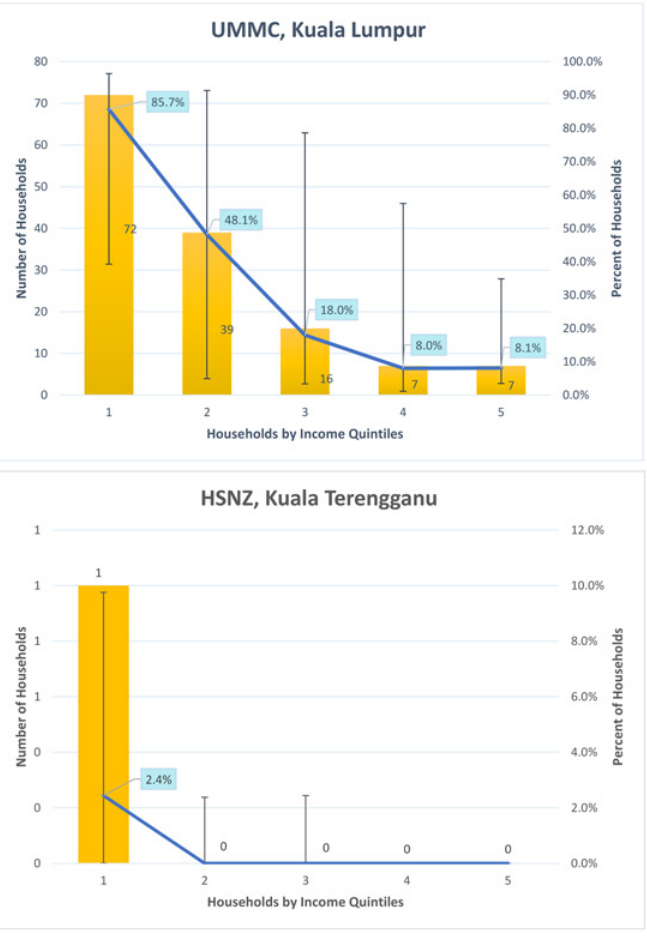
Fig 2. Households with catastrophic healthcare payments due to acute gastroenteritis requiring hospitalization. Note : Error bars represent range of results from varying thresholds of catastrophic payments from 5% to 20%. UMMC, University of Malaya Medical Centre; HSNZ, Hospital Sultanah Nur